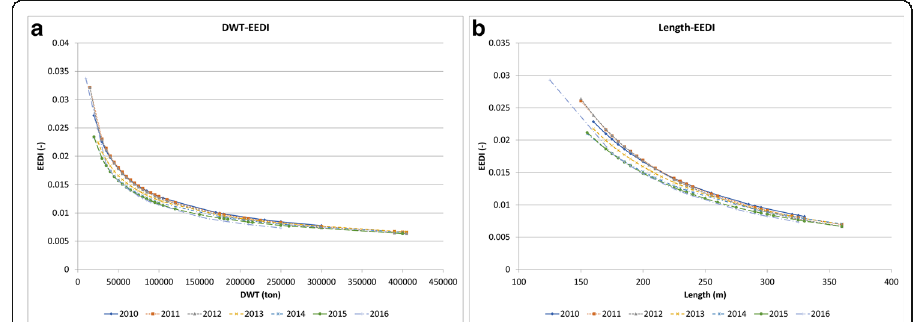
Fig. 1 OLS estimated lines for EEDI based on DWT (left) and Length (right)